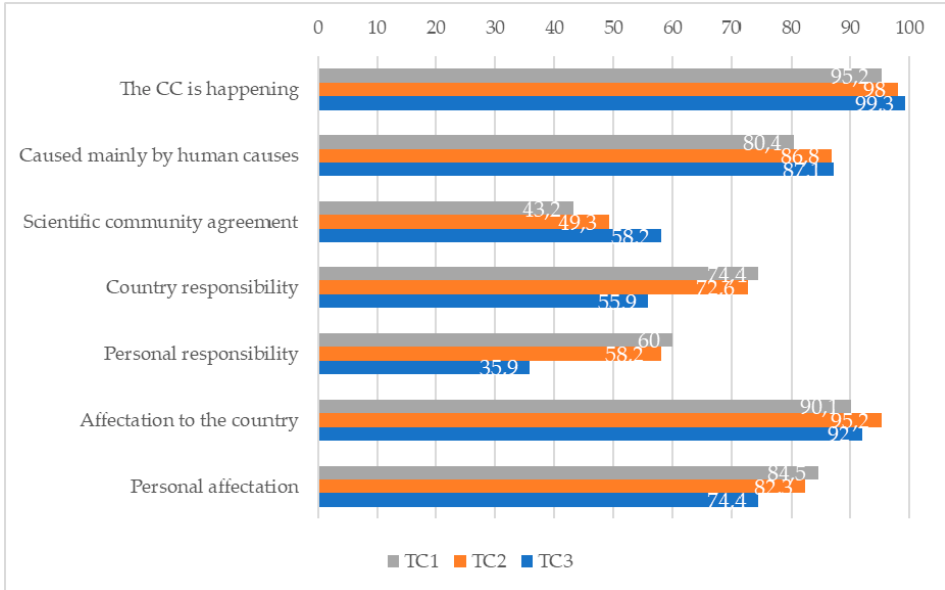
Figure 6. General opinion questions on CC in the different contexts analysed.